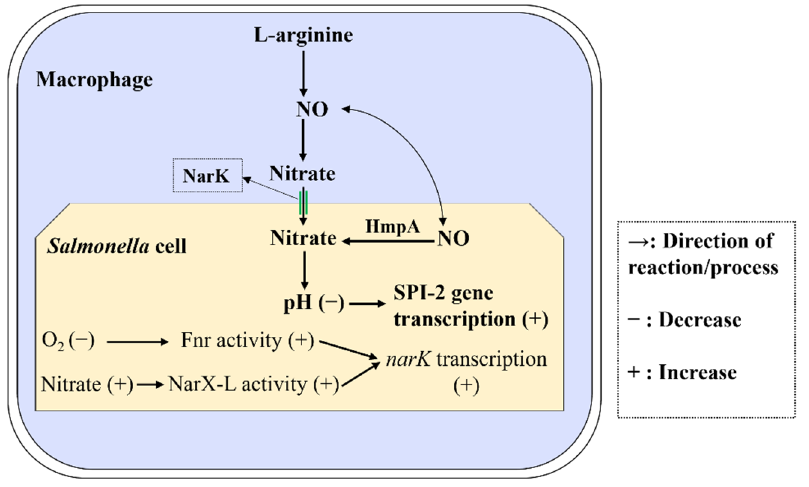
Figure 7. Schematic representation of nitrate utilization in S. Typhimurium during systemic infec- tion.